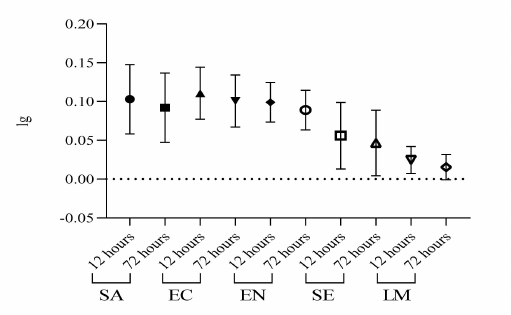
Figure 5. Logarithmic reduction trend line for bacterial survival at 12 h compared to 72 h; SA- Staphylococcus aureus , EC— Escherichia coli , EN— Enterococcus sp., SE— Salmonella enterica , LM— Listeria monocytogenes ; ( p < 0.05).